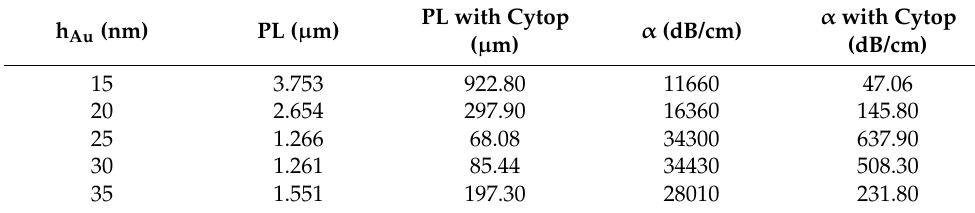
Table 4. The plasmonic propagation